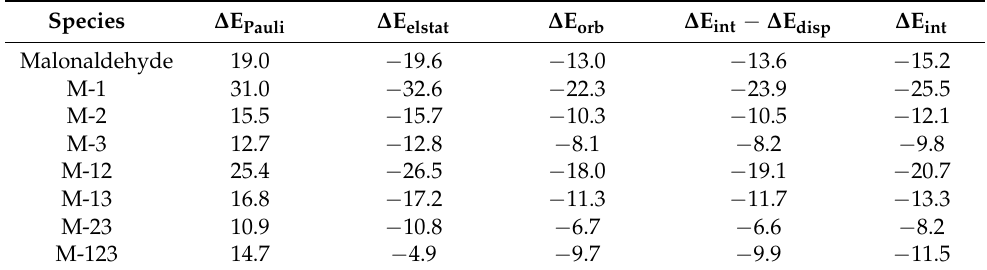
(in kcal/mol); ∆ E Pauli —the Pauli repulsion, ∆ E elstat —the electrostatic term, ∆ E orb —the orbital inter- action energy, ∆ E disp —the dispersion interaction energy term (assumed to be equal to − 1.6 kcal/mol for all systems), ∆ E int —the total interaction energy.